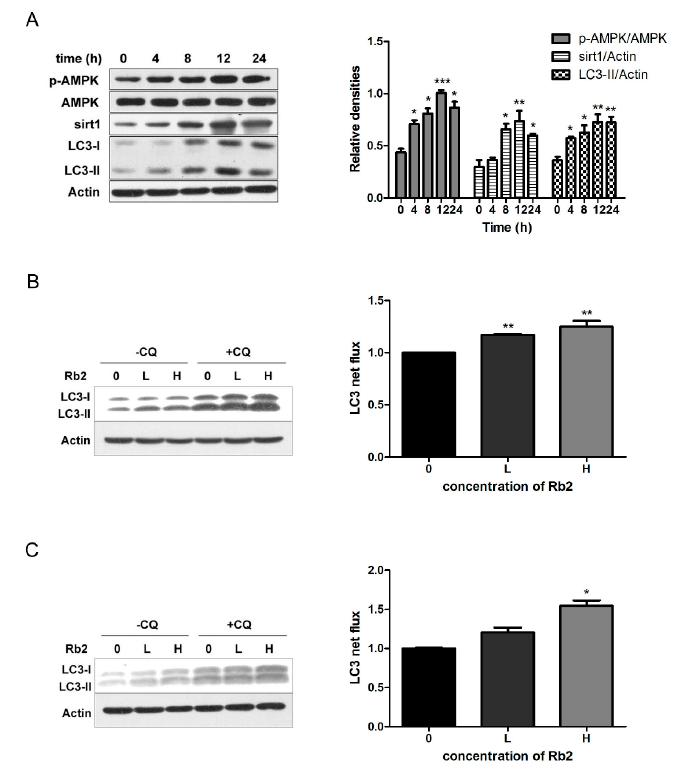
Figure 5. Rb2 promoted autophagic flux by increasing sirt1 expression and AMPK phosphorylation in a time- and dose-dependent manner in hepatocytes. The levels of LC3-II, P62, sirt1, and the p-AMPK/AMPK ratio were evaluated by Western blotting analysis after Rb2 (50 µ mol/L) treatment for 0, 4, 8, 12, and 24 h in HepG2 cells ( A ). Autophagic flux was evaluated by Western blotting analysis after Rb2 (0: DMSO, L: 10 µ mol/L, H: 50 µ mol/L) treatment with and without chloroquine (CQ) (25 µ mol/L) for 12 h in HepG2 cells ( B ) and primary mouse hepatocytes ( C ). Data are expressed as mean ± SE from three independent experiments. * p < 0.05, ** p < 0.01, and *** p < 0.001 compared with vehicle (DMSO)-treated group (Control).